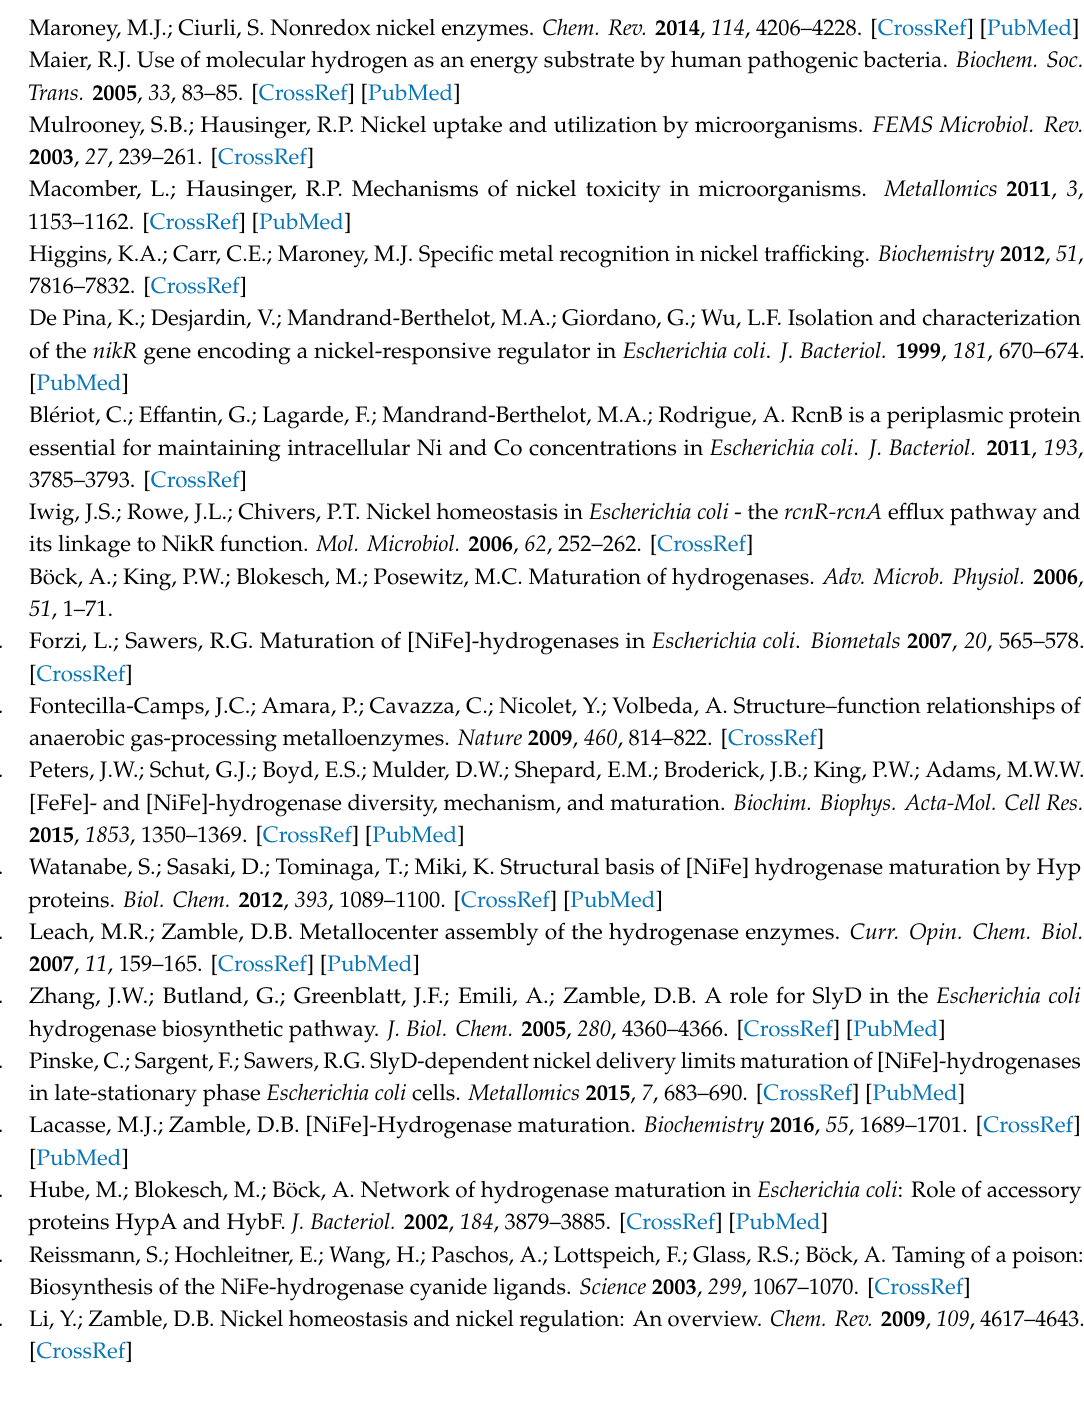
Table S1: The metal binding properties of the Ni(II)-responsive metalloregulators, Table S2: The metal binding properties of the Ni(II)